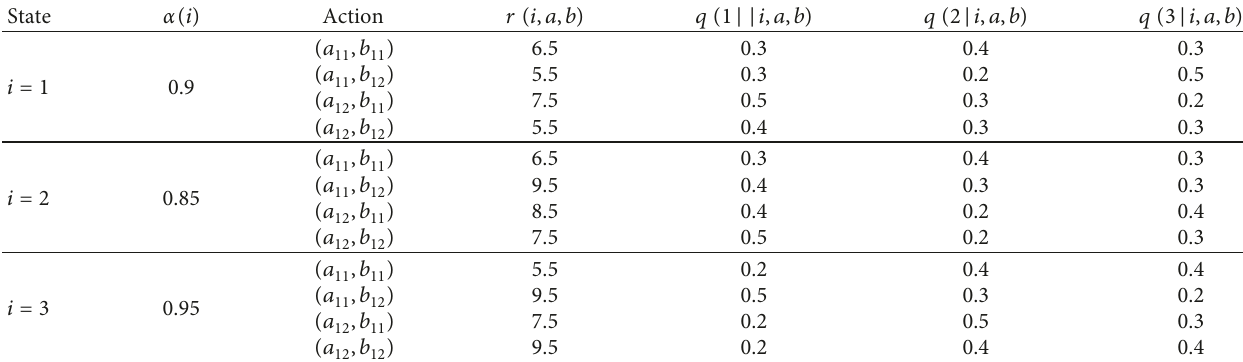
Table 1: The model parameter